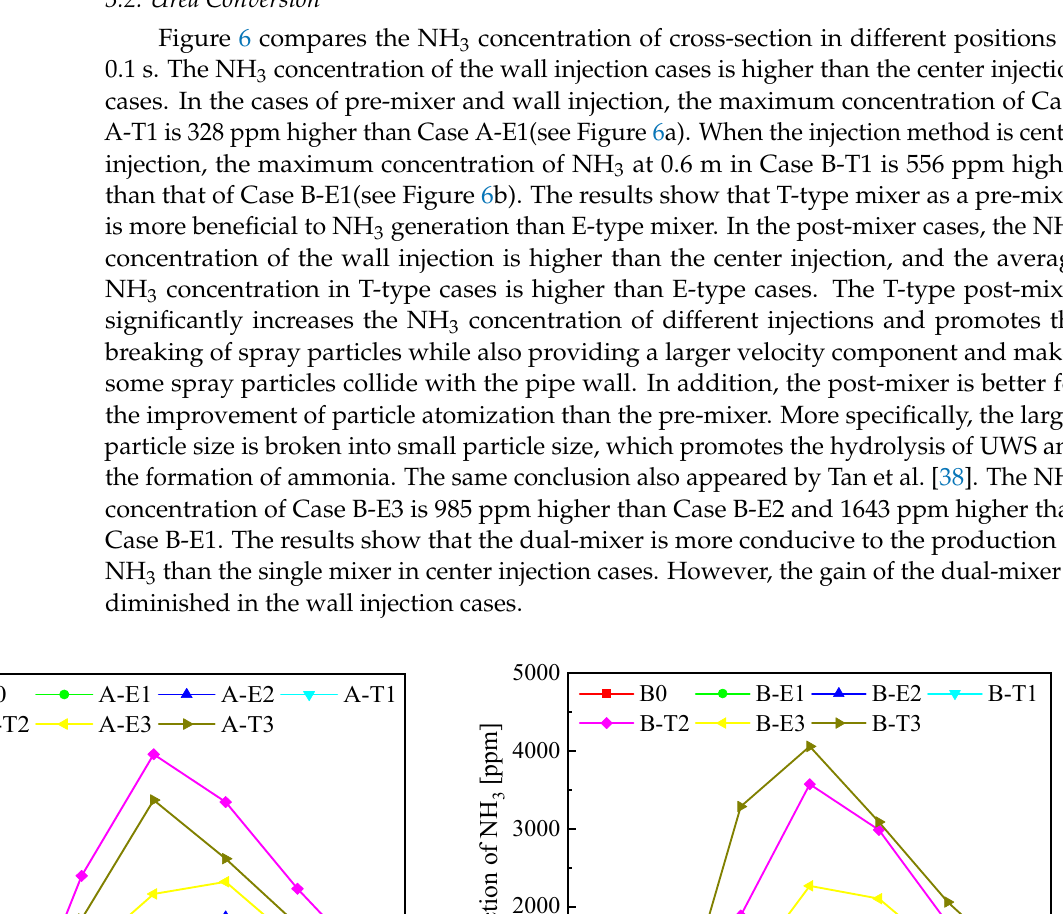
( b ) NH 3 concentration for center injection Figure 6. The NH 3 concentration. Figure 6. The NH 3